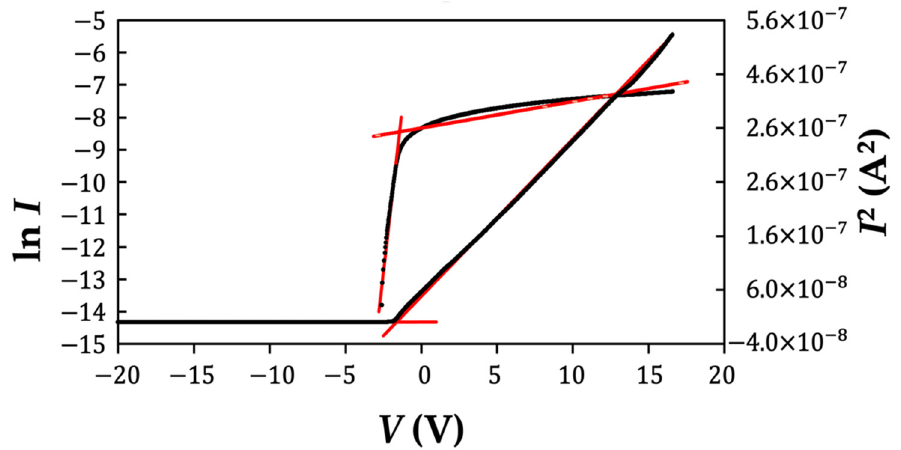
2 - V curve and the ln I curve of the experimental IVCP of Figure Figure 8. Comparison of the (cid:1835) (cid:2870) - (cid:1848) curve and the ln (cid:1835) curve of the experimental IVCP of Figure 4. Figure 8. Comparison of the I